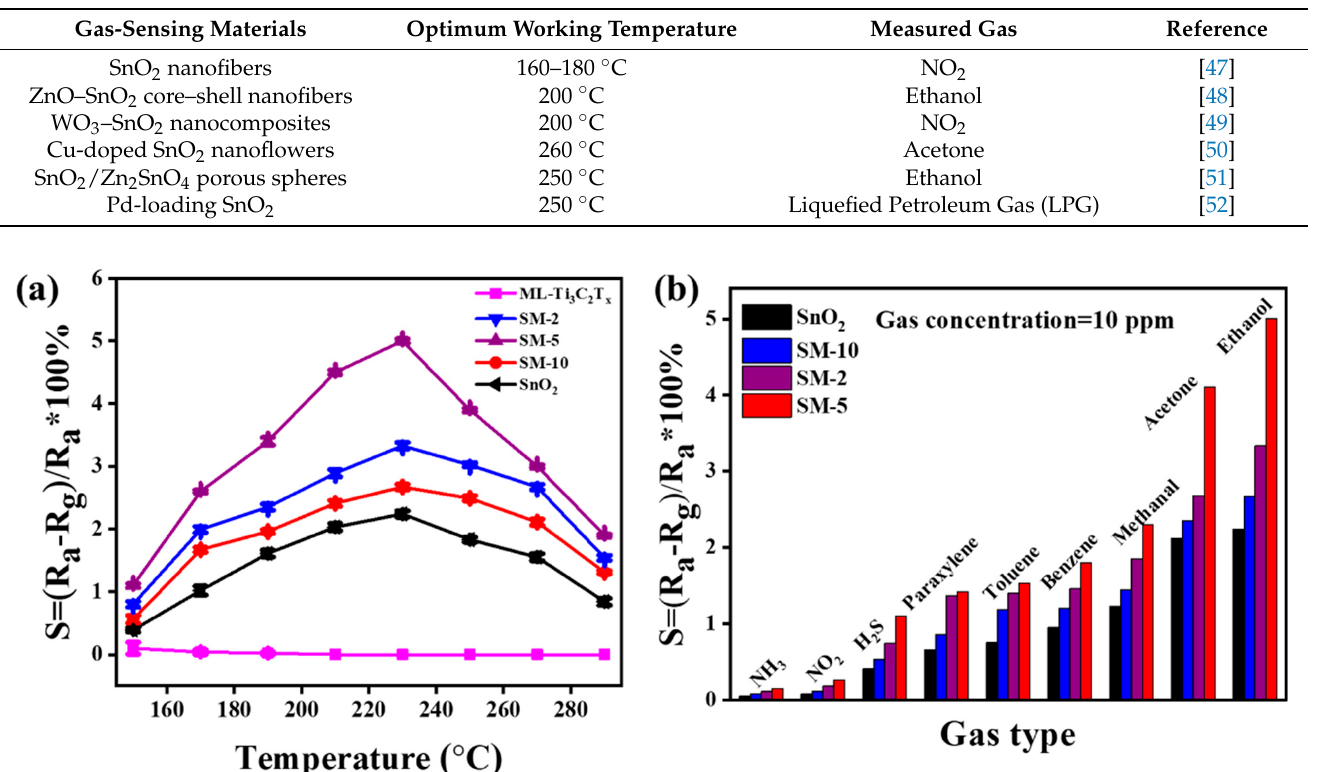
Table 1. Optimum working temperature of different SnO 2 composites.